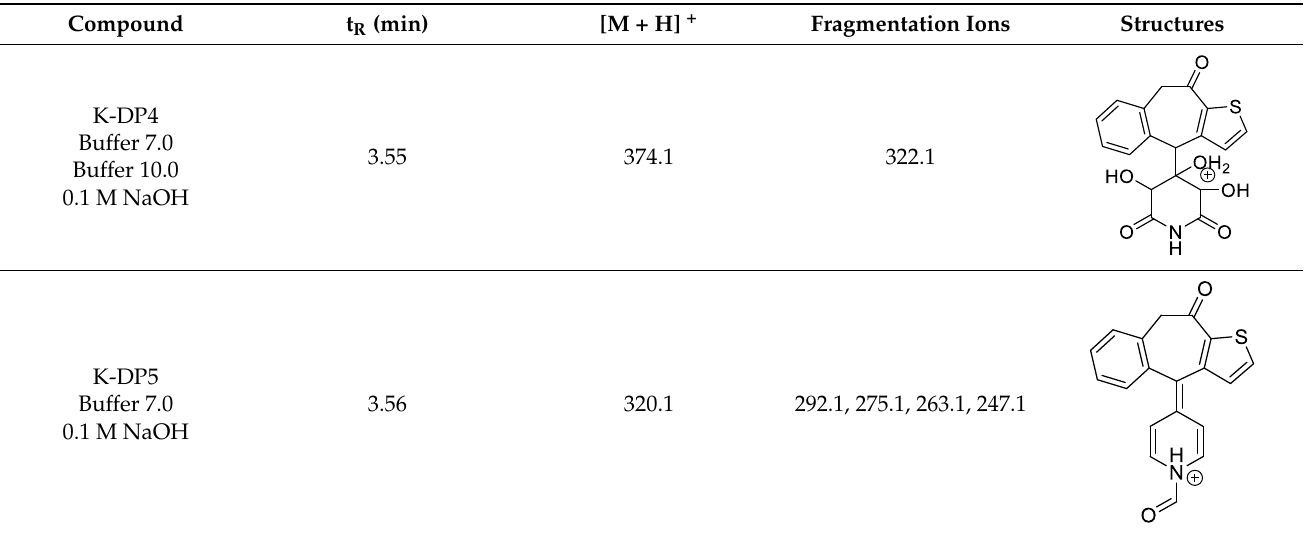
It is worth mentioning that the products K-DP3 and K-DP4 have not been reported so far. In turn, K-DP1, K-DP2 and K-DP5 were previously detected after degradation of